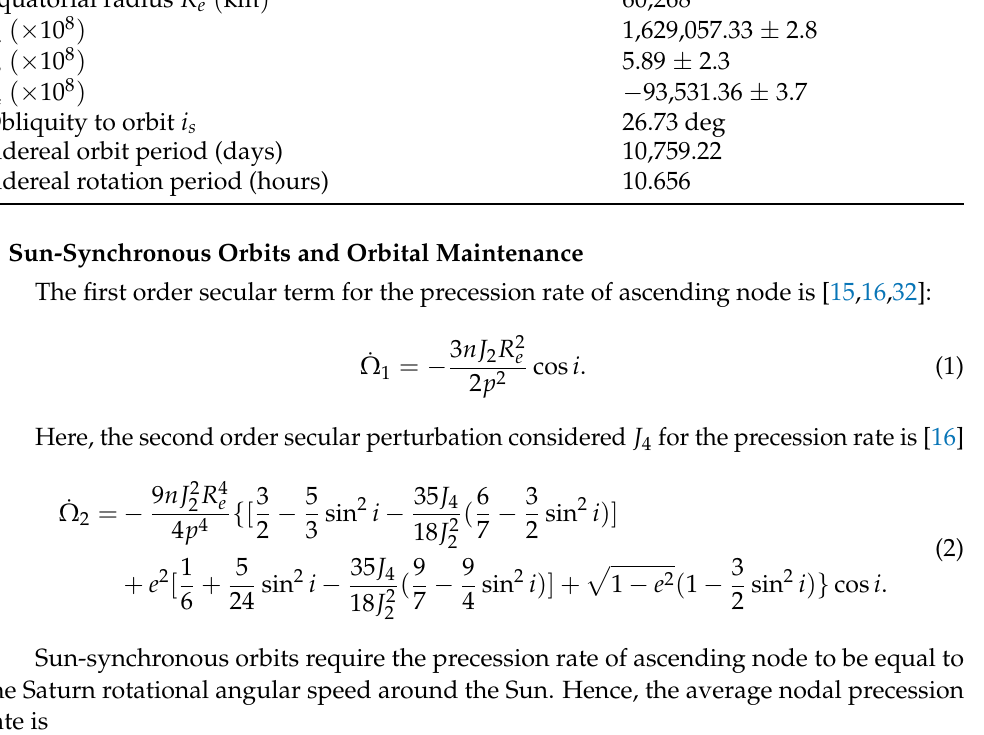
Table 1. Some parameters for basic model of Saturn. µ ( km 3 s − 2